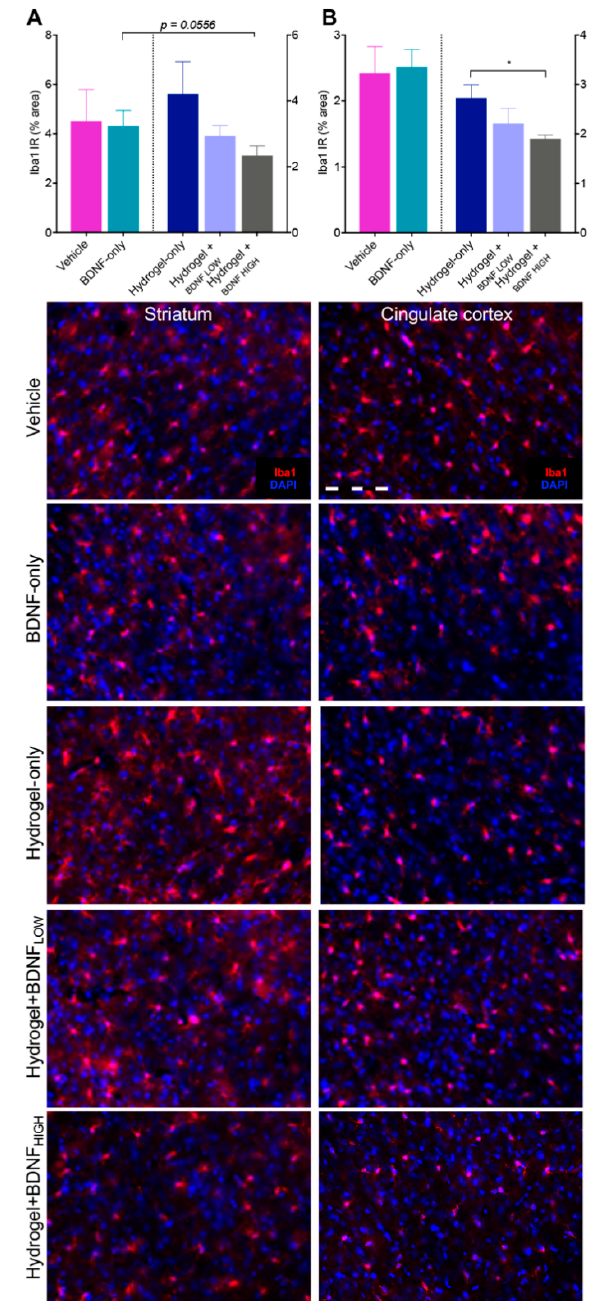
Figure 4. Effects of BDNF and delivery vehicle on microgliosis following dMCAo. Hydrogel + BDNF HIGH treatment reduces ionized calcium-binding adapter molecule 1 immunoreactivity (Iba1 IR) in the ipsilateral ( A ) corpus striatum and ( B ) cingulate cortex. Representative photomicrographs of Iba1 (red) and DAPI nuclear stain (blue) at 20 × magnification from each treatment group and ROI are shown below. Vehicle ( n = 5), BDNF-only ( n = 5), hydrogel-only ( n = 5), hydrogel + BDNF LOW ( n = 4–5), hydrogel + BDNF HIGH ( n = 5). Scale bar = 20 µm. IR = immunoreactivity. Error bars indicate the mean ± SEM; * p < 0.05.